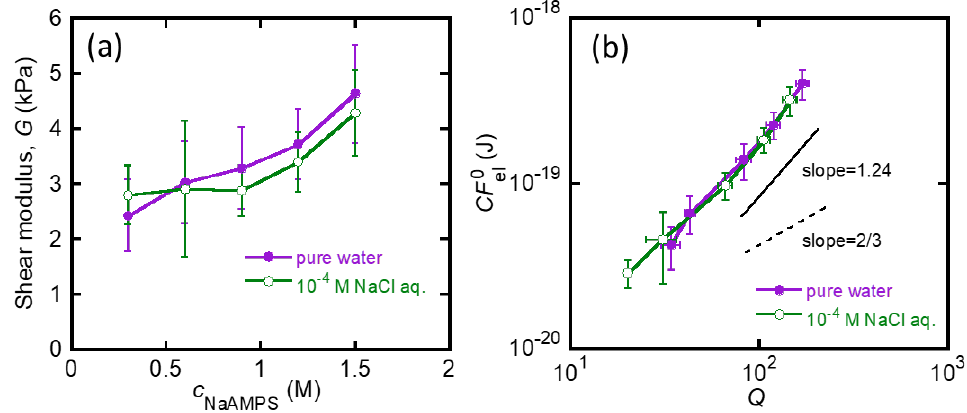
Figure 3. ( a ) Relationship between the shear modulus, G , and c NaAMPS of the St-tetra-PEG gels swol- len in pure water or 10 −4 M NaCl aqueous solution; ( b ) relationship between 𝐶𝐹 el0 and Q for the same St-tetra-PEG gels.